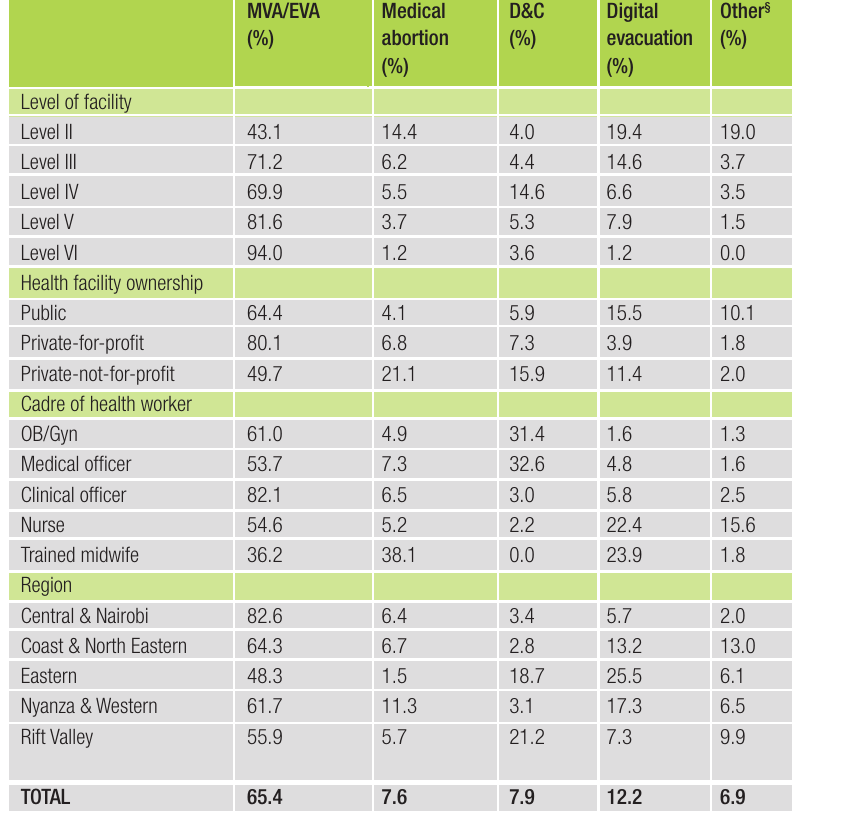
Technology used for uterine evacuation among PAC clients by facility level, clinician, ownership and region, Kenya, 2012 (n=